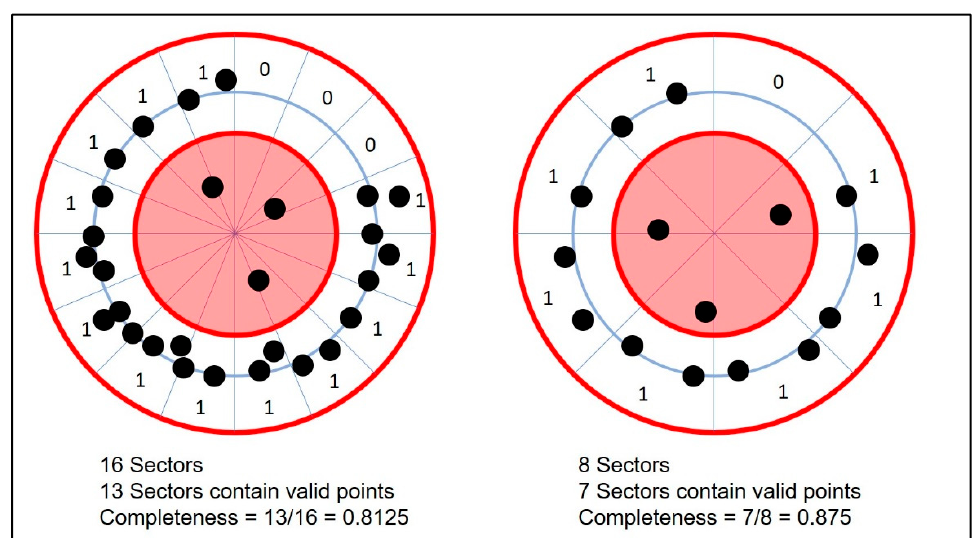
Figure A2. An example of how Circumferential Completeness Index (CCI) can be applied to lower-resolution point clouds using fewer sector divisions with a trade-off in precision. Even with reduced precision, CCI can still provide a comparable measure of circumferential coverage of a stem, provided that there is sufficient resolution to fit a circle to the stem slice.